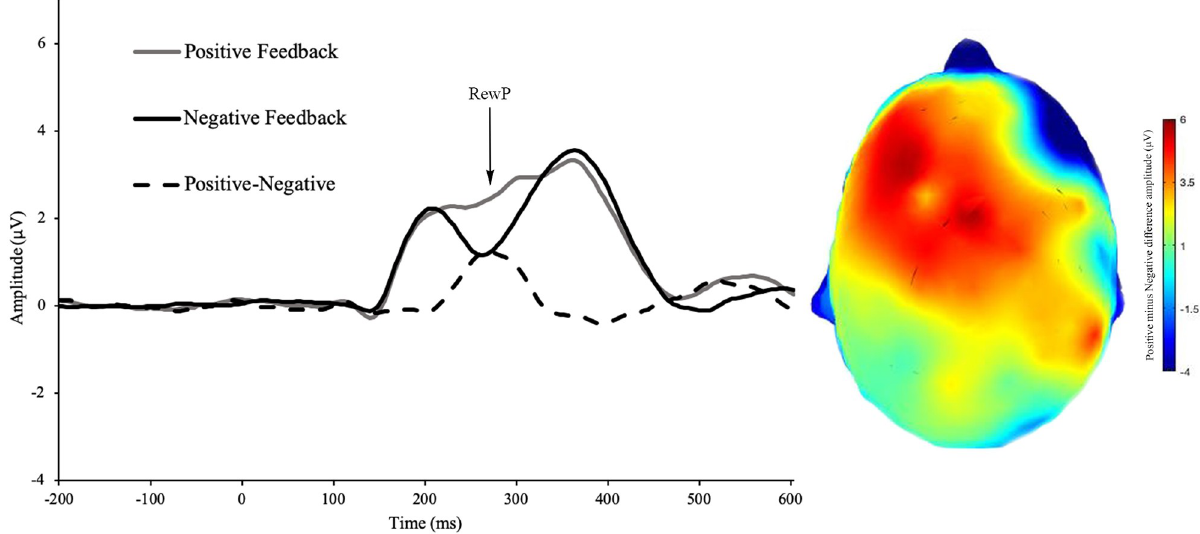
Fig 3. RewP for correct feedback, incorrect feedback, and the difference wave during the doors task. Scalp distribution of the difference wave (correct minus incorrect feedback).